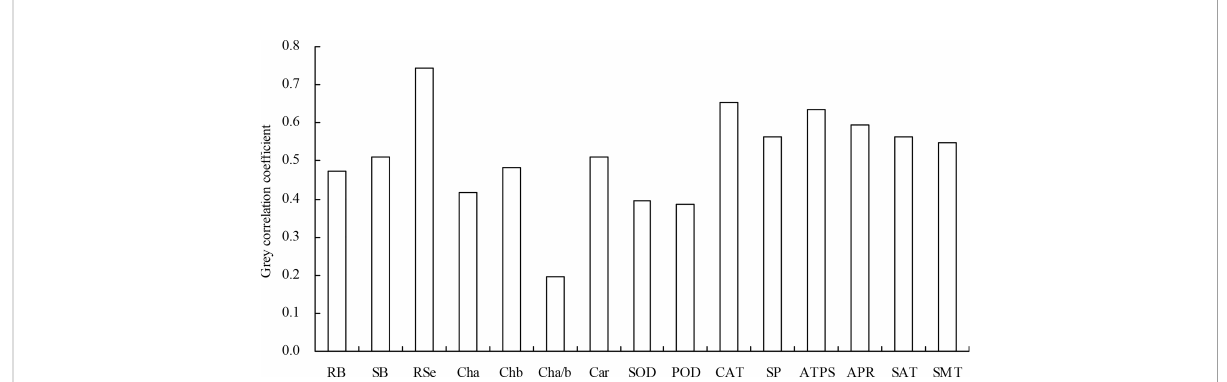
FIGURE 7 Grey correlation coef fi cient of the biomass, root total Se content, photosynthetic pigment content, antioxidant enzyme activity, soluble protein content, and Se metabolism-related enzyme activity with the shoot total Se content. RB, root biomass; SB, shoot biomass; RSe, root total Se content; Cha, chlorophyll a content; Chb, chlorophyll b content; Cha/b, chlorophyll a / b ; Car, carotenoid content; SOD, SOD activity; POD, POD activity; CAT, CAT activity; SP, soluble protein content; ATPS, ATPS activity; APR, APR activity; SAT, SAT activity; SMT, SMT